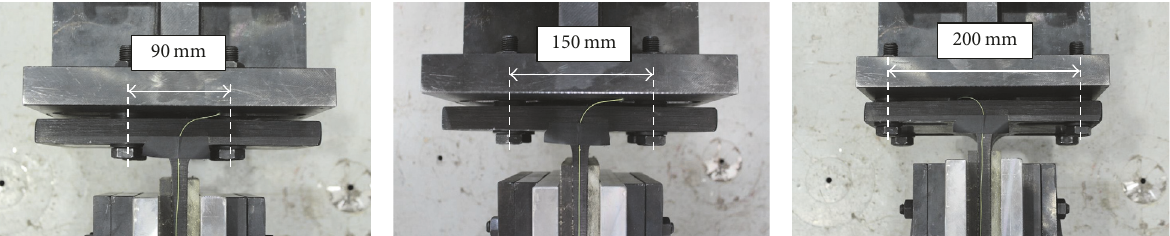
Figure 7: Three specimens with different bolt pitches.